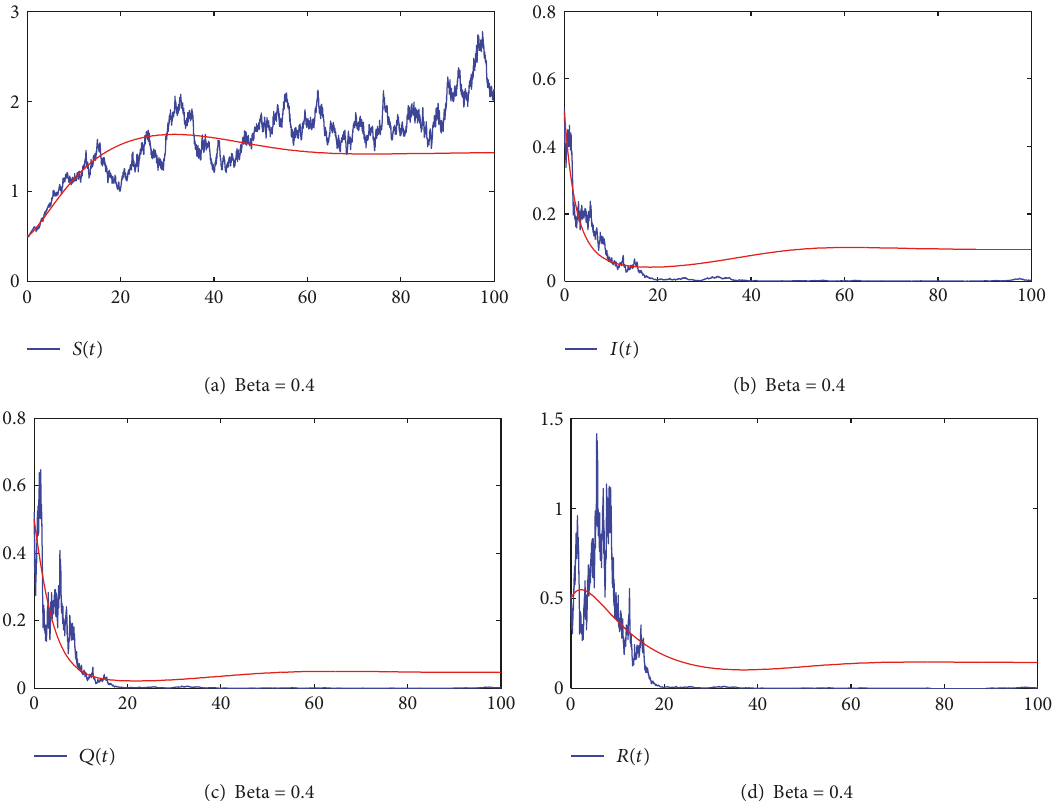
Figure 7: Computer simulation of the paths 𝑆(𝑡), 𝐼(𝑡), 𝑄(𝑡) , and 𝑅(𝑡) for models (1) and (3) for parameter values Λ = 0.2; 𝑑 = 0.1; 𝛽 = 0.7; 𝛾 = 0.1; 𝛿 = 0.2; 𝛼